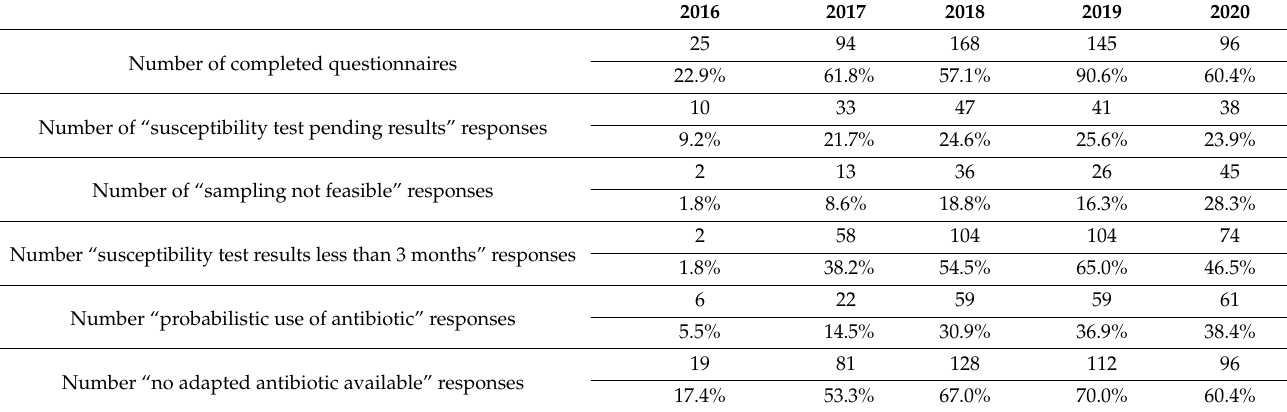
Figure 5. Distribution of CIAs from 2014 to 2020 regardless of species and route of administration. Table 3. Responses to the automatic questionnaire generated by the software for each prescription of CIAs.